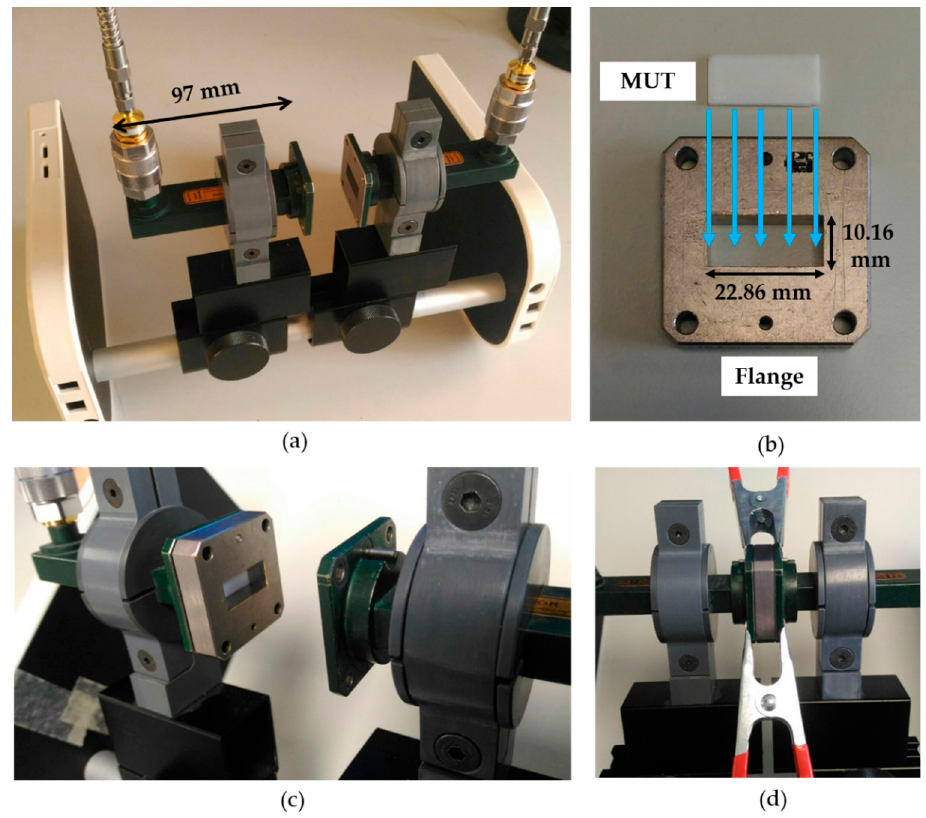
Figure 3. X-band rectangular waveguide measurement system: ( a ) instrument including two waveguide halves connected to the VNA; ( b ) MUT inserted into the flange aperture; ( c ) flange with MUT inside connected to the left waveguide halve; ( d ) waveguide halves closed until sealed.